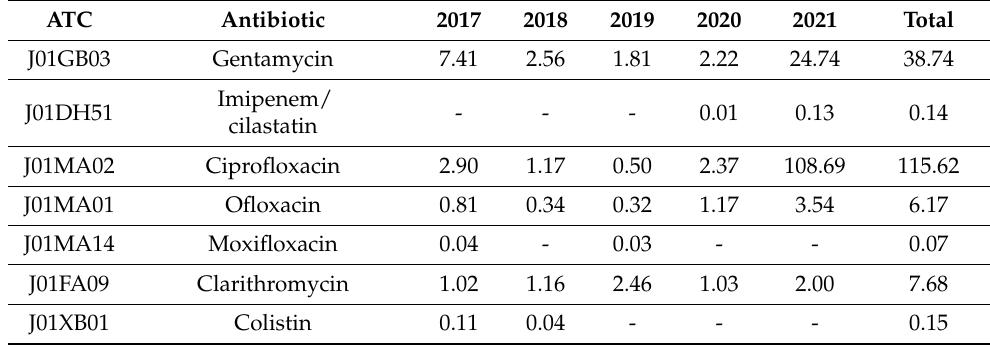
Table 6. FDA category C antibiotics commonly prescribed expressed in DDDs/100 bed days.